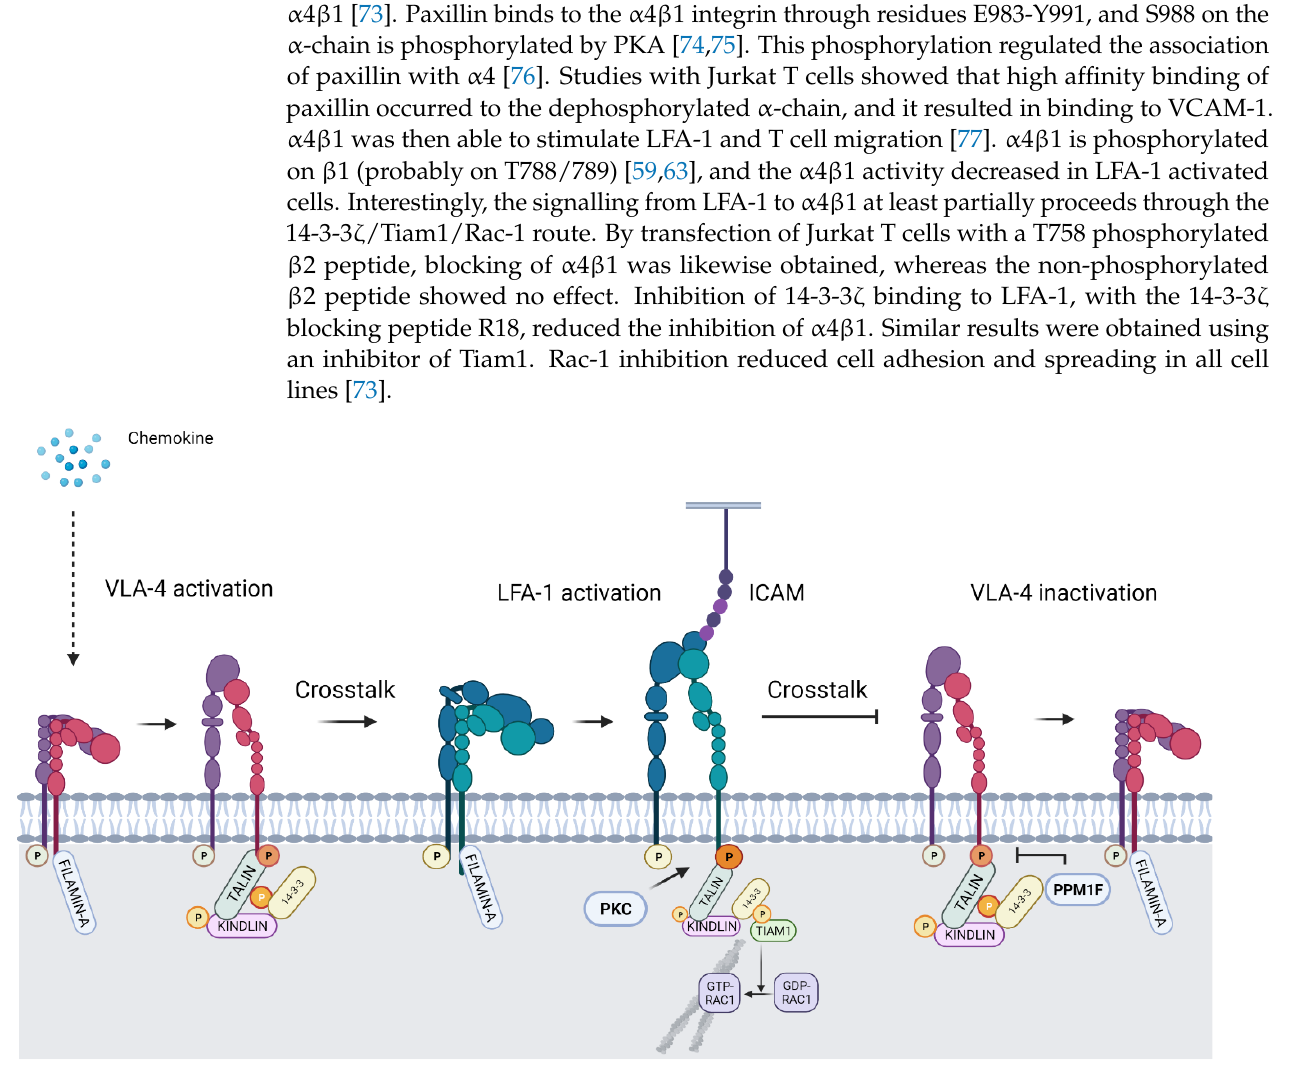
Figure 5. Crosstalk from VLA-4 to LFA-1, and from the activated LFA-1 to VLA-4. In the resting state VLA-4 ( α 4 β 1) is phosphorylated on the α -chain and filaminA is bound to the unphosphorylated β -chain. Upon activation, the β 1-chain becomes phosphorylated, and through 14-3-3 ζ /Tiam 1/Rac-1, the binding to the cytoskeleton is increased. Talin and kindlin-3 become associated with the β 1-tail. LFA-1 is then activated and binds to an ICAM on a neighbouring cell, or crosstalks to an activated VLA-4 integrin, which loses the activation associated proteins and allows filaminA binding, resulting in inactivation.